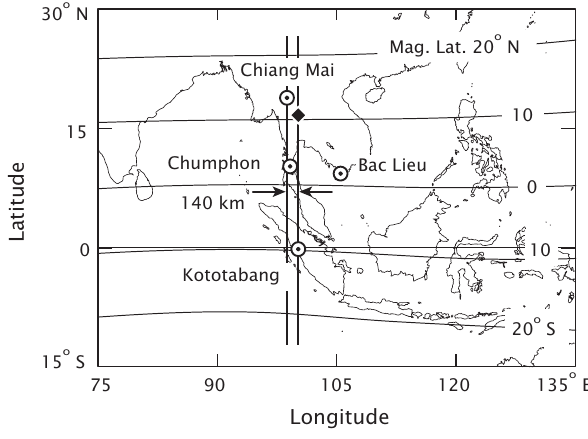
Fig. 2. Southeast Asia low-latitude ionospheric network (SEALION). The conjugate point of Kototabang is indicated with the closed